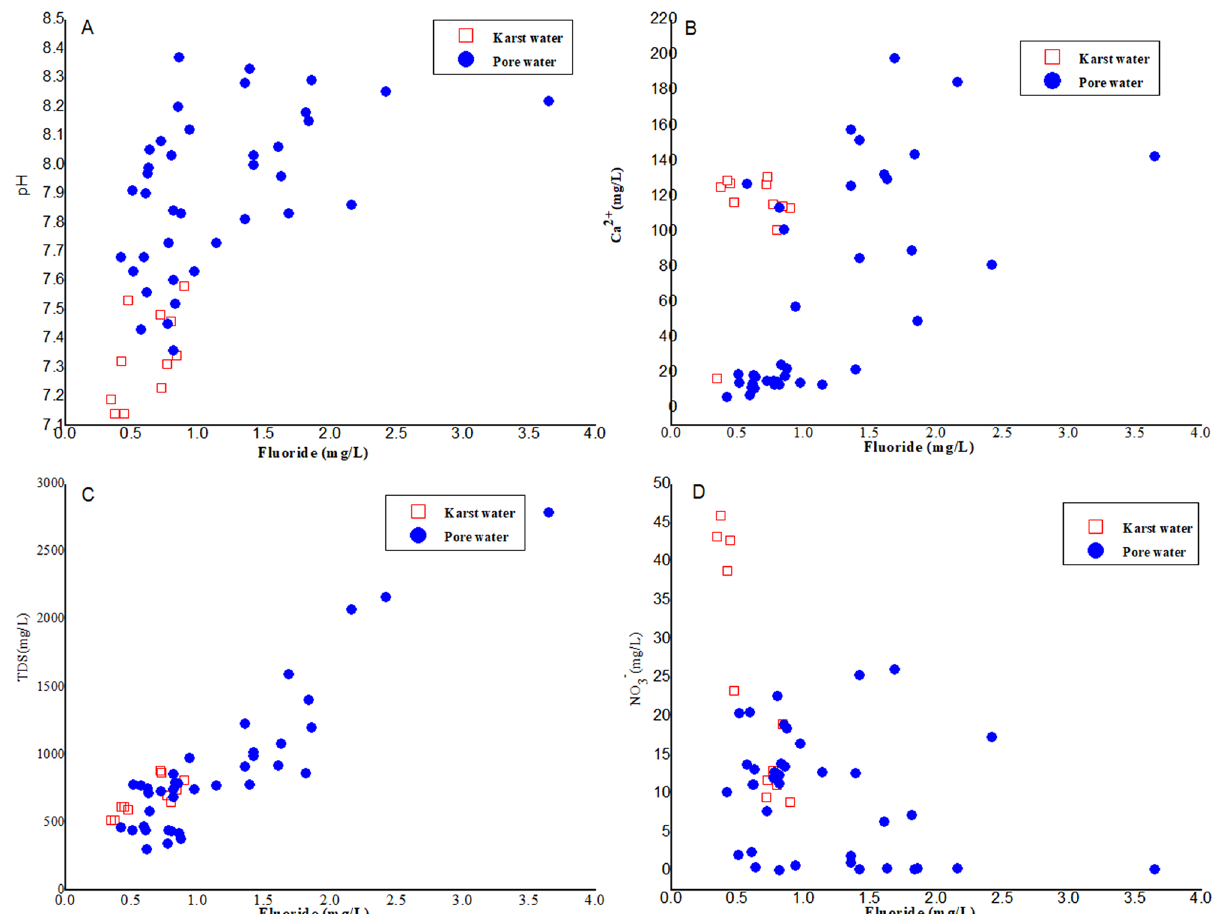
Figure 5. Relationship between the fluoride concentration with major ions in groundwater sources of Huaibei: ( A ) pH, ( B ) Ca 2+ , ( C ) TDS, ( D ) NO 3 −